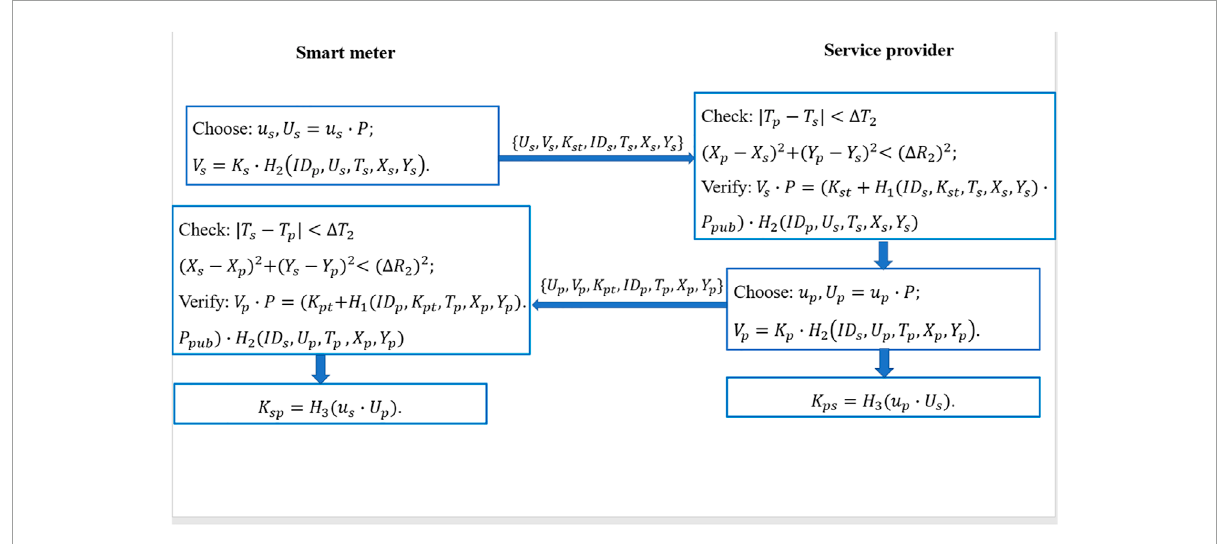
FIGURE 2 Authentication phase of designed protocol.